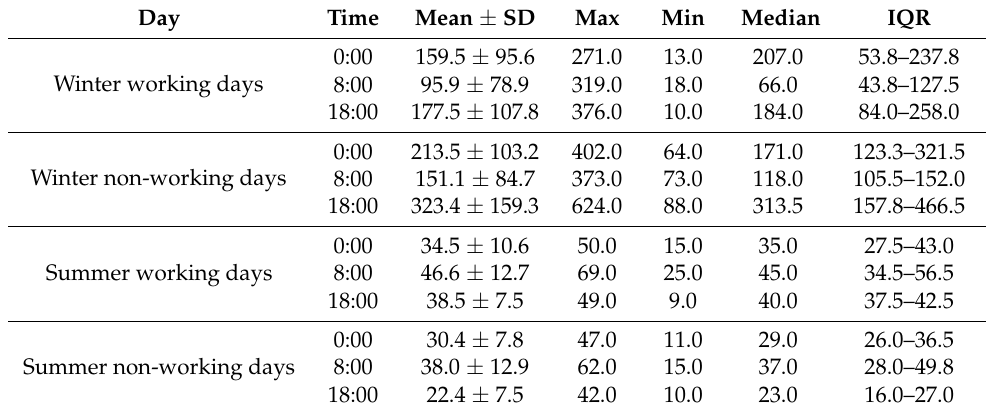
Table 2. Summary of the descriptive statistics of the PM 2.5 data in the study